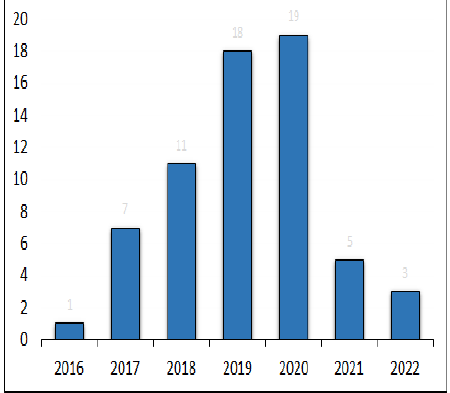
Figure 9. Year Wise Distribution of Articles.